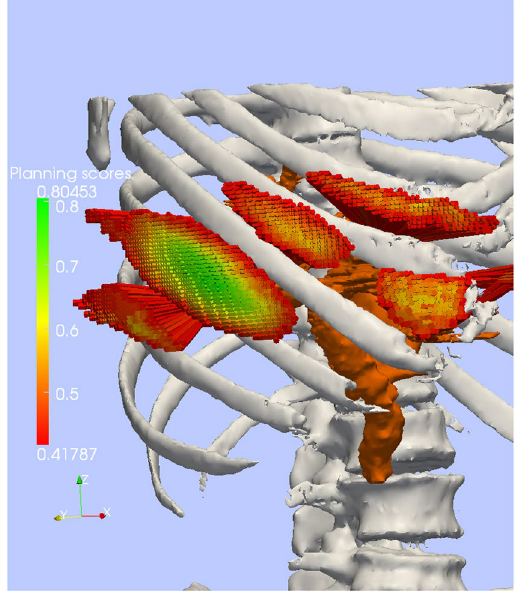
Figure 3. Reference paths (colored), bile ducts (brown) and bone (white). On our paths reaching the bile ducts scoring reveals best paths in the central green area mainly between the 6th and 7th rib. Path coloring corresponds to the quality of the path deduced from the soft